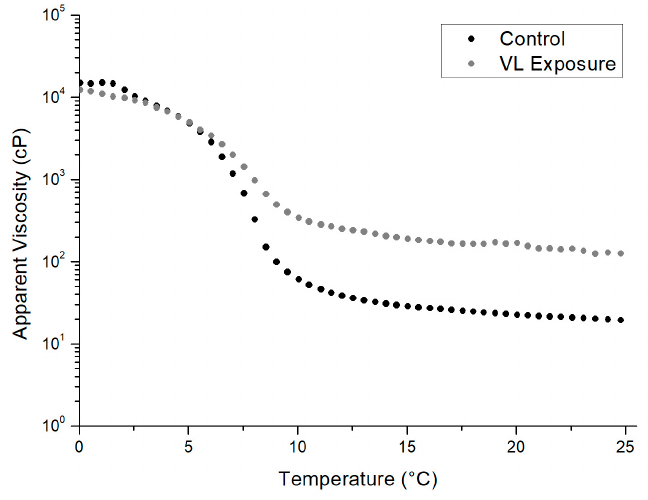
Figure 4. Apparent viscosity of the hydrogels exposed to visible light (VL) during the cooling ramp.